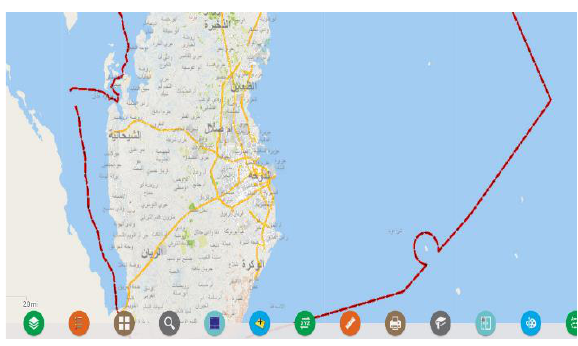
Figure 4 . National Mapping